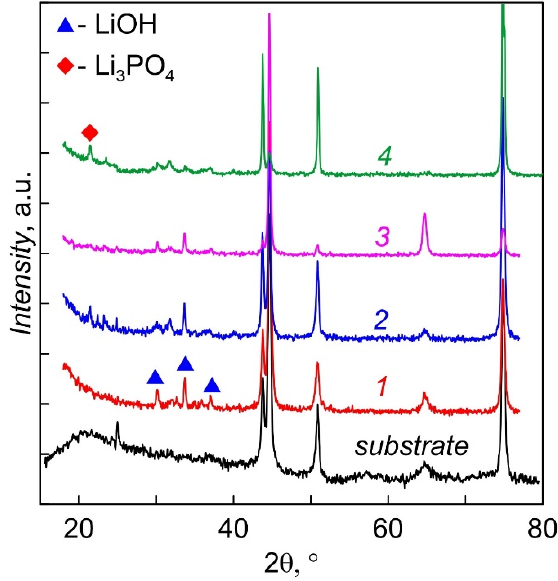
Figure 5. XRD patterns of LiPON films. 1 as-deposited. 2, 3, 4, post-annealed under temperature: 2— 200, 3—250, 4—300 °C.